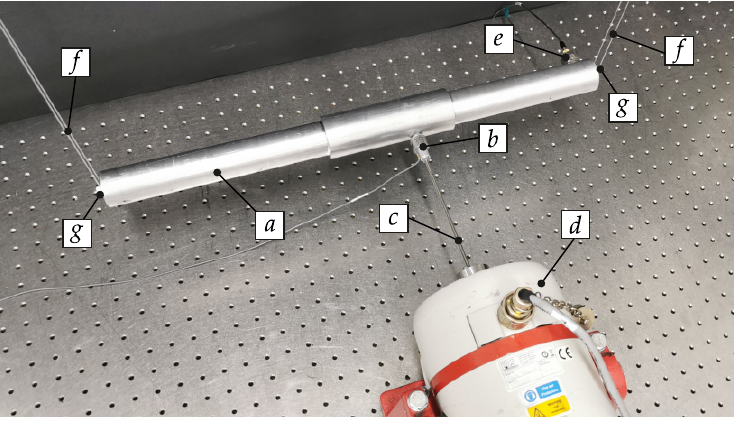
Figure 9. Illustration of the test setup—created by